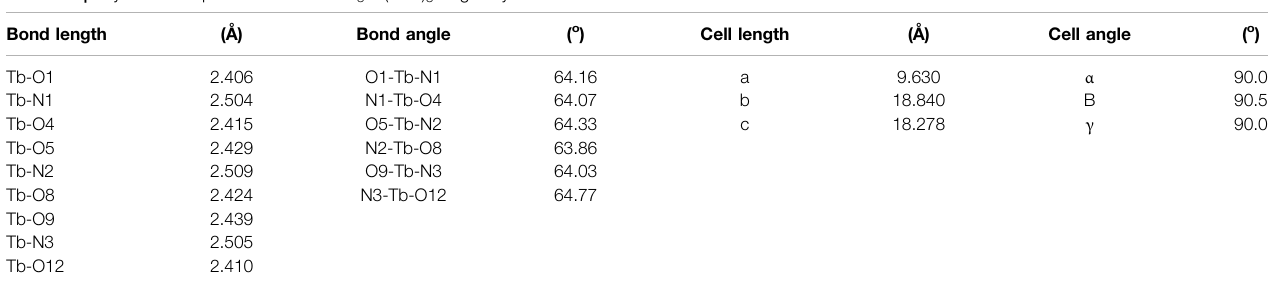
TABLE 1 | Key structural parameters of an Na 3 Tb(PDA) 3 single